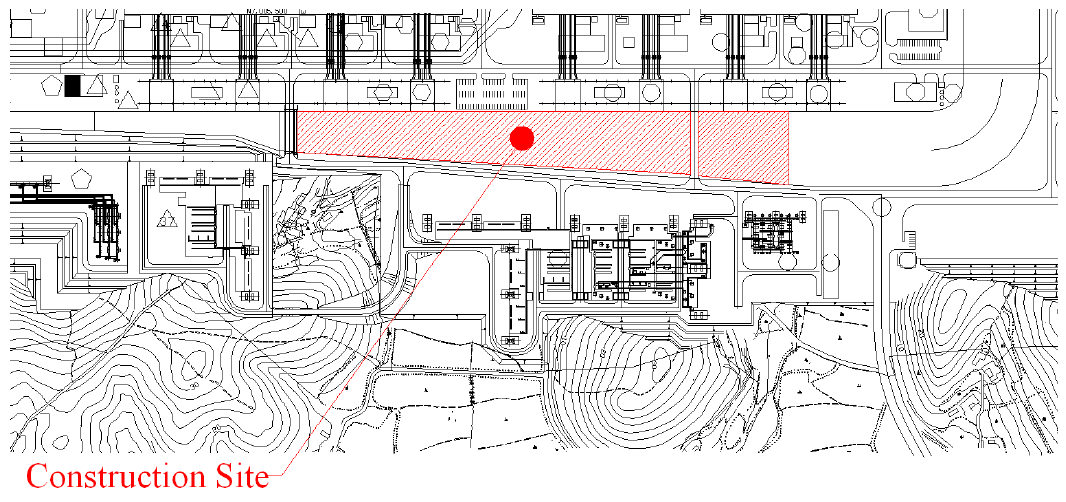
Figure 2. Construction site.